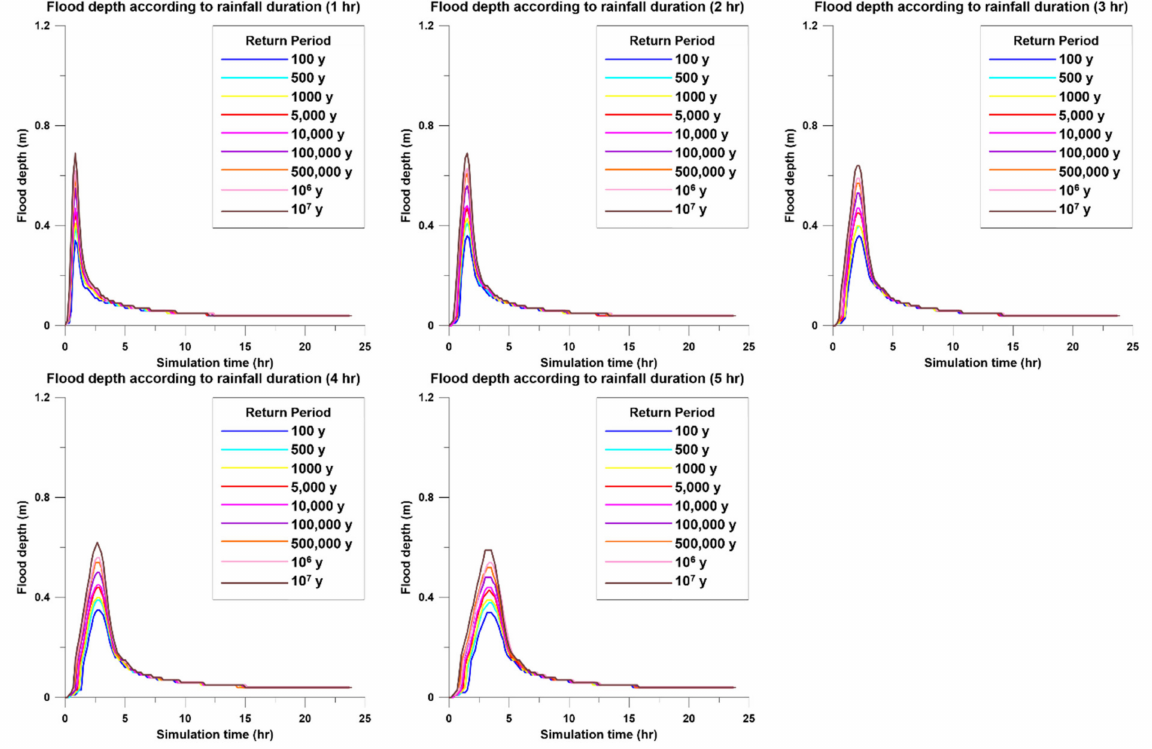
Figure 7. Inflow boundary conditions for grid no. 15092 (control building, NPP